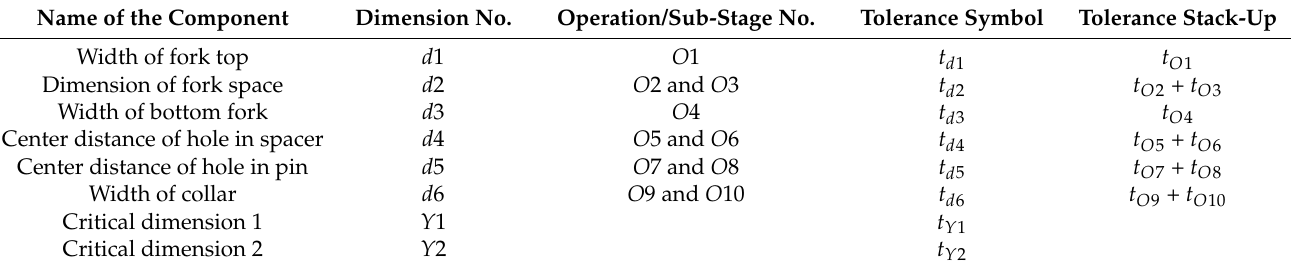
Figure 8. Knuckle joint assembly (KJA). Table 5. Dimension and tolerance symbol of knuckle joint assembly.